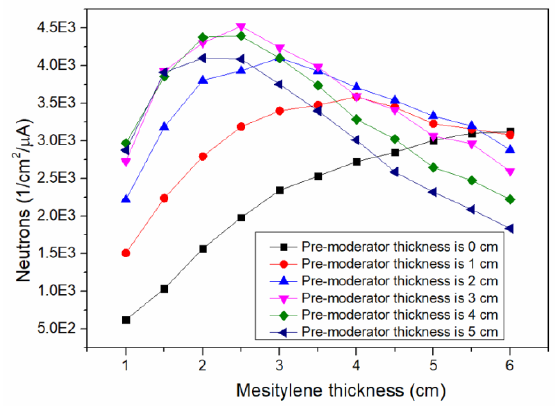
Fig. 4. Cold neutron intensity as a function of pre-moderator and moderator